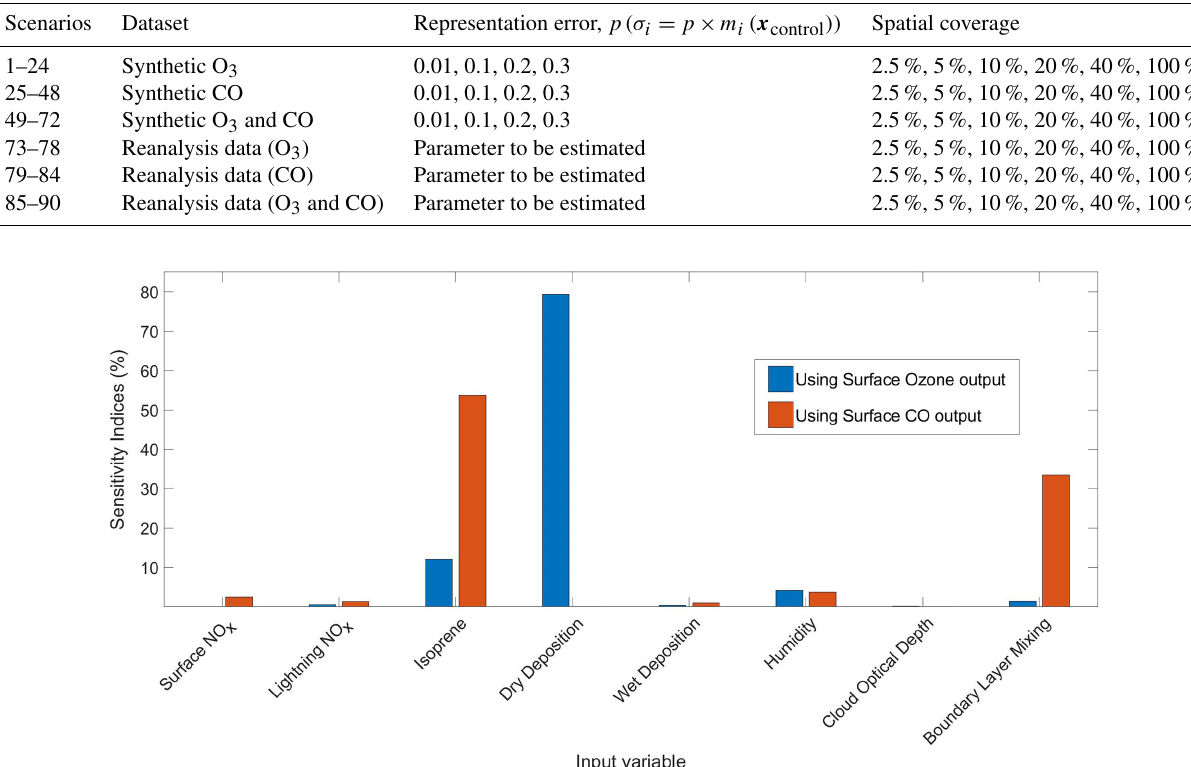
Figure 4. Sensitivity indices representing the percentage of the variance in surface O 3 and CO over the USA and Europe in the FRSGC/UCI model output due to changes in the scaling parameter associated with each of the eight model processes (Table